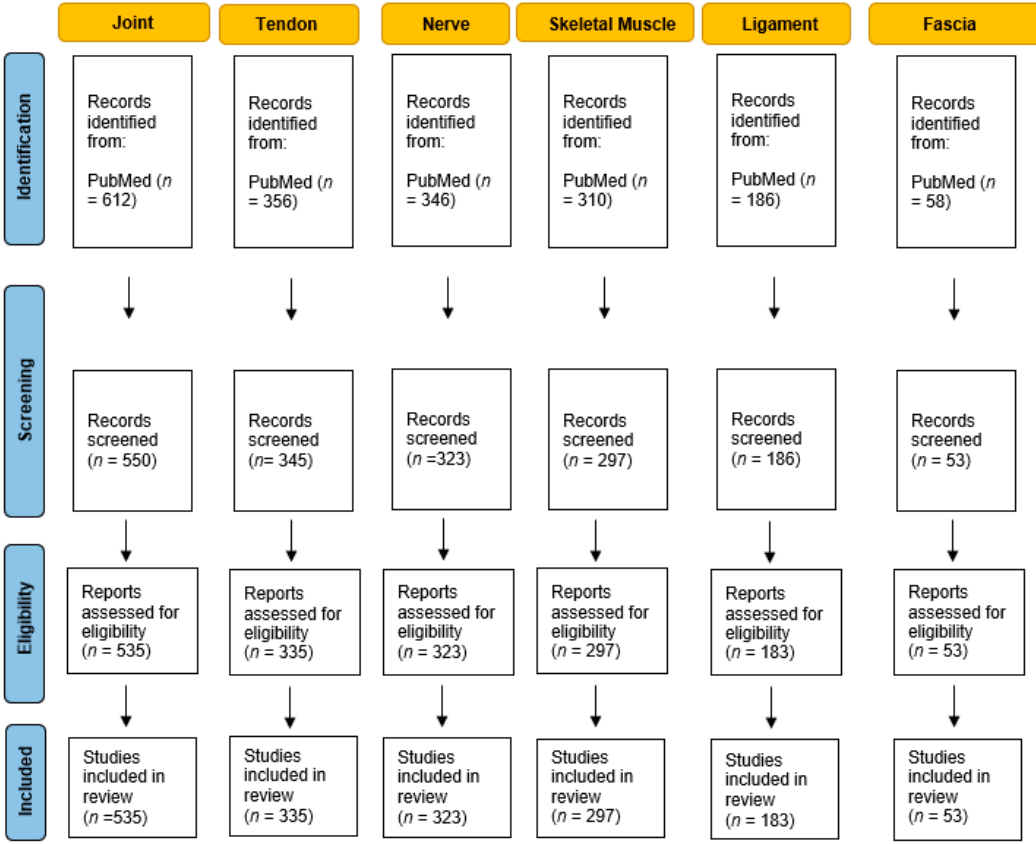
Figure 1. Study flow diagram shows bibliometric analysis protocol for different anatomical muscu- loskeletal structures and ultrasound examination.